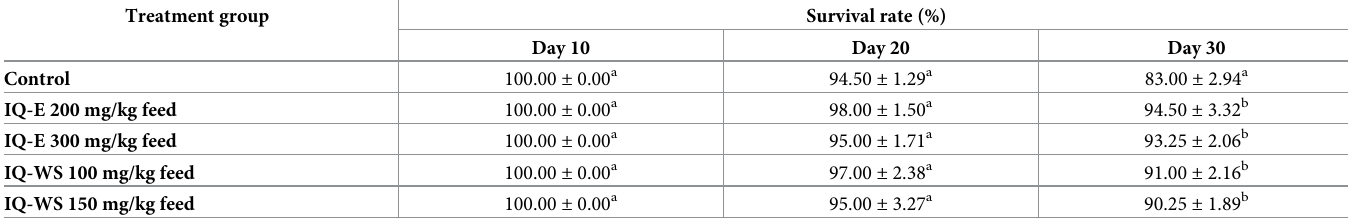
Table 4. Effects of IQ extracts on survival rate of the healthy